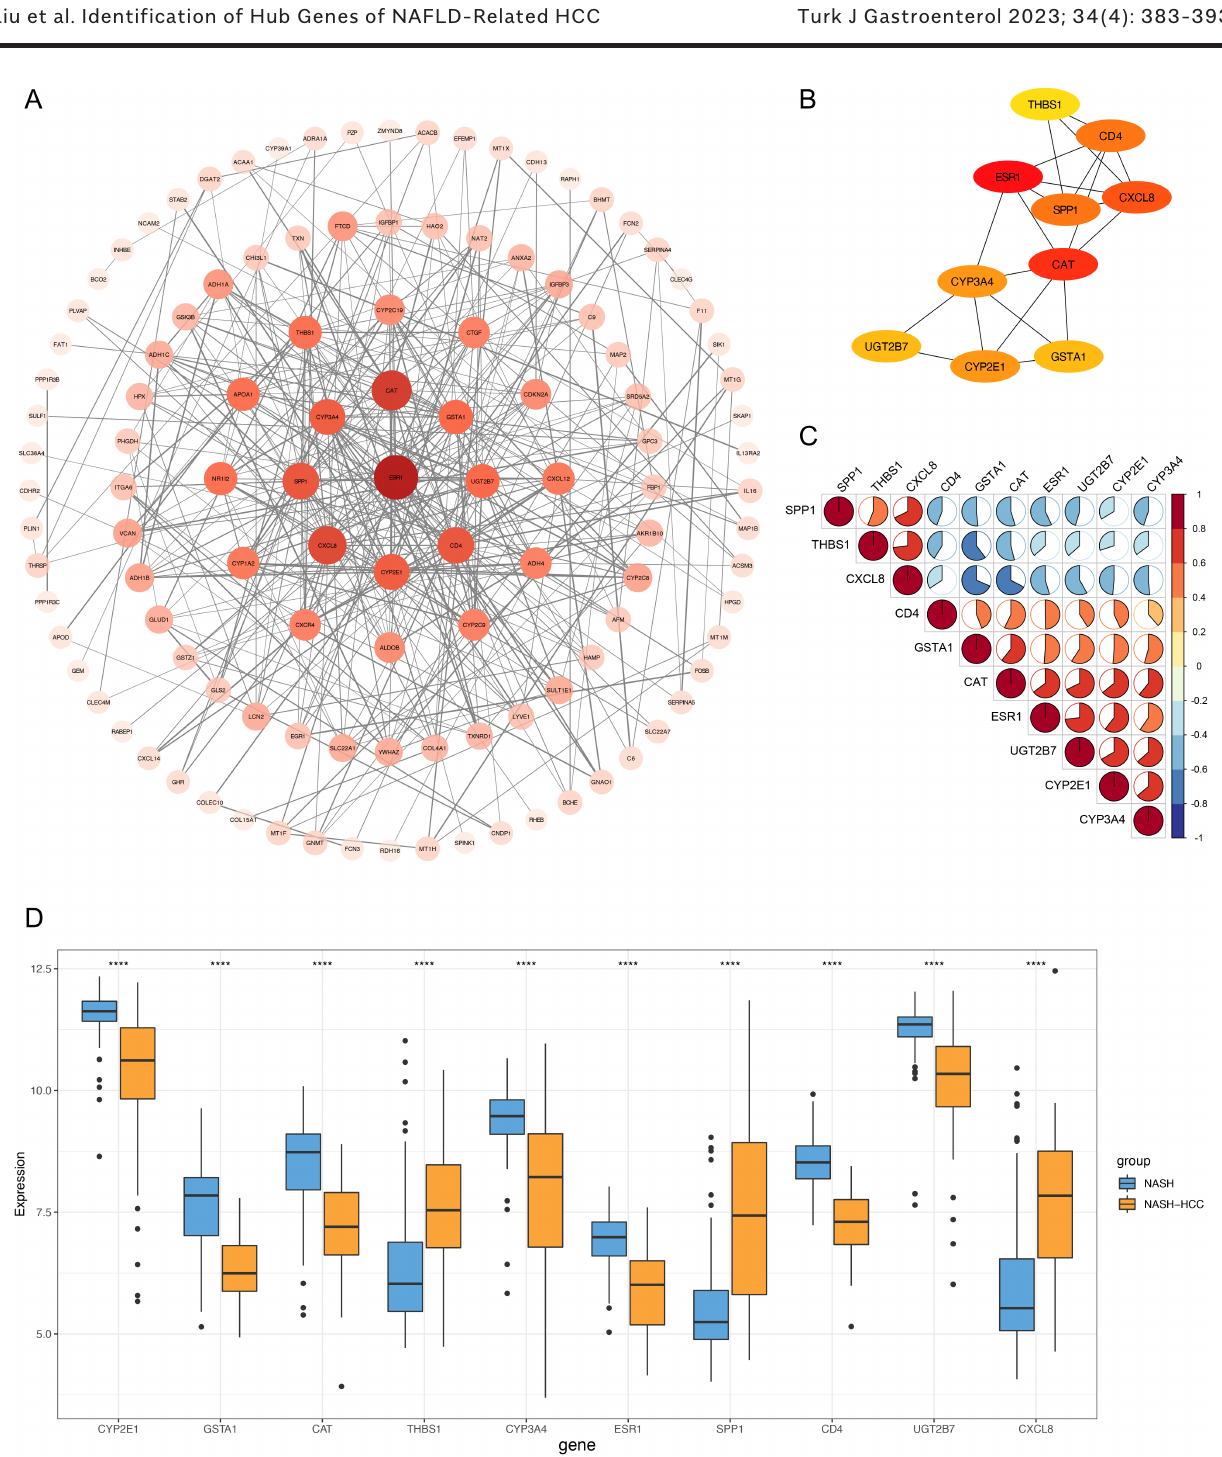
Figure 2. Identification of hub genes. (A) Construction of the PPI network of DEGs. The color depth and shape size of the nodes are positively correlated with degree. (B) The top 10 hub genes at protein level. (C) The correlation between the 10 hub genes. Positive correlation was marked with red and negative with blue. (D) The expression of 10 hub genes in NASH tissues and NASH-HCC tissues in GSE164760. DEG, differentially expressed genes; HCC, hepatocellular carcinoma; NASH, non-alcoholic steatohepatitis; PPI, protein–protein